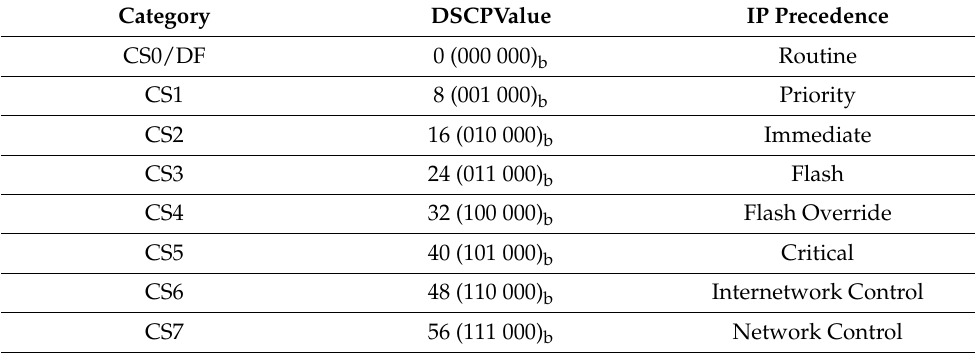
Table 2. DSCP CS category.